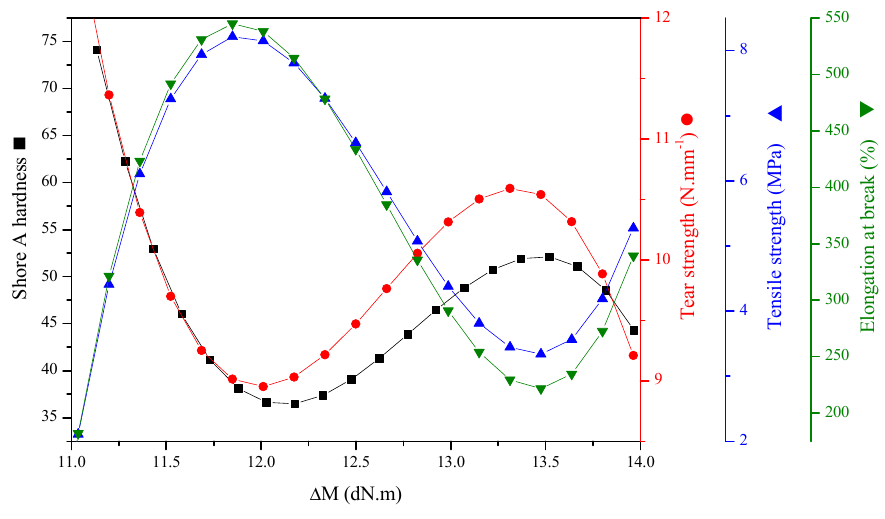
Figure 6. Influence of ∆ M on the mechanical properties of the blends.